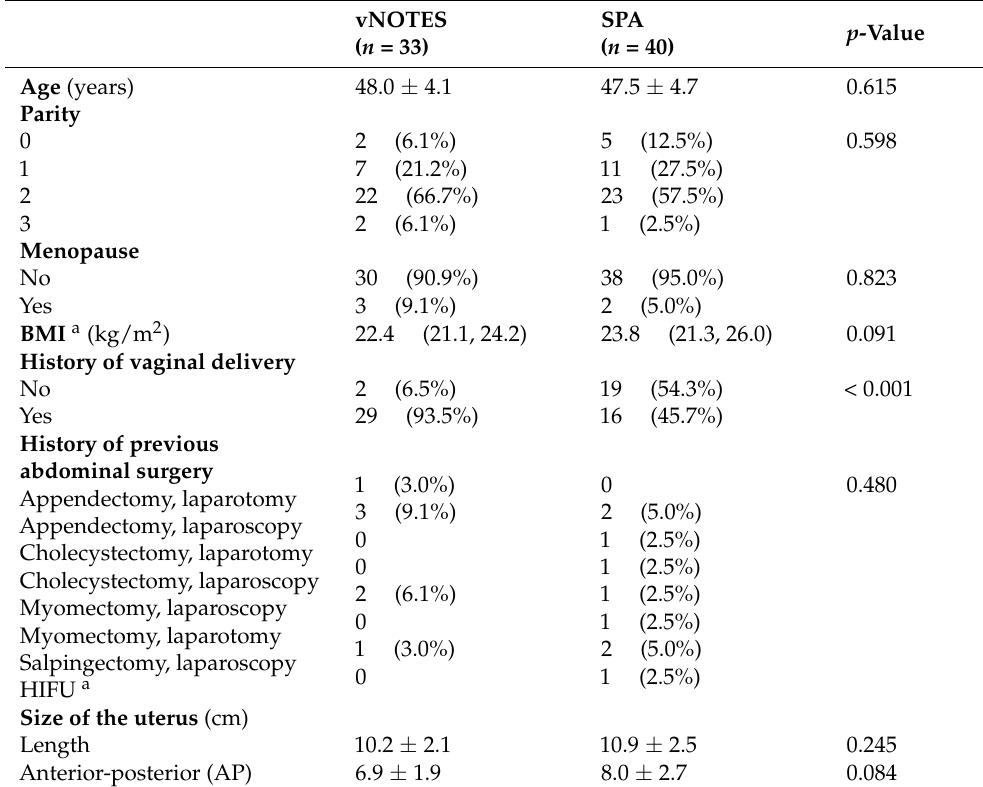
Table 1. Baseline characteristics of the patients in the vNOTES and SPA groups.